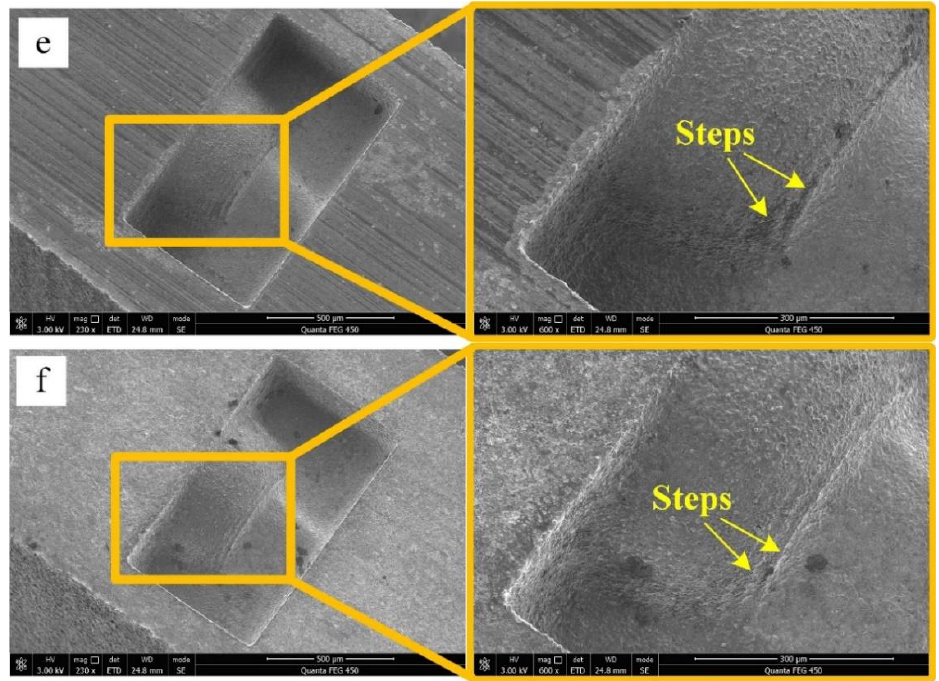
Figure 3. Micro-EDM results of FQ-microelectrodes with different taper angles: ( a ) 0°; ( b ) 2°; ( c ) 4°; ( d ) 6°; ( e ) 8°; ( f ) 10°.